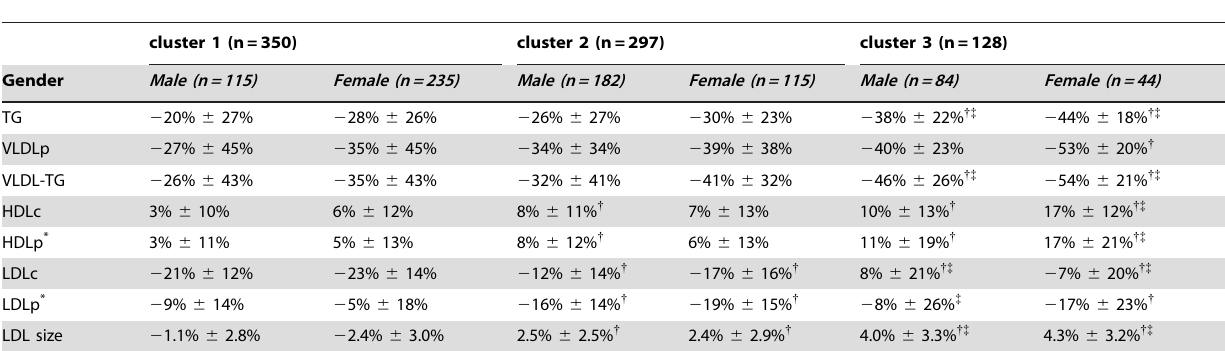
Table 2. Percent changes after fenofibrate intervention, grouped by NMR clustering.